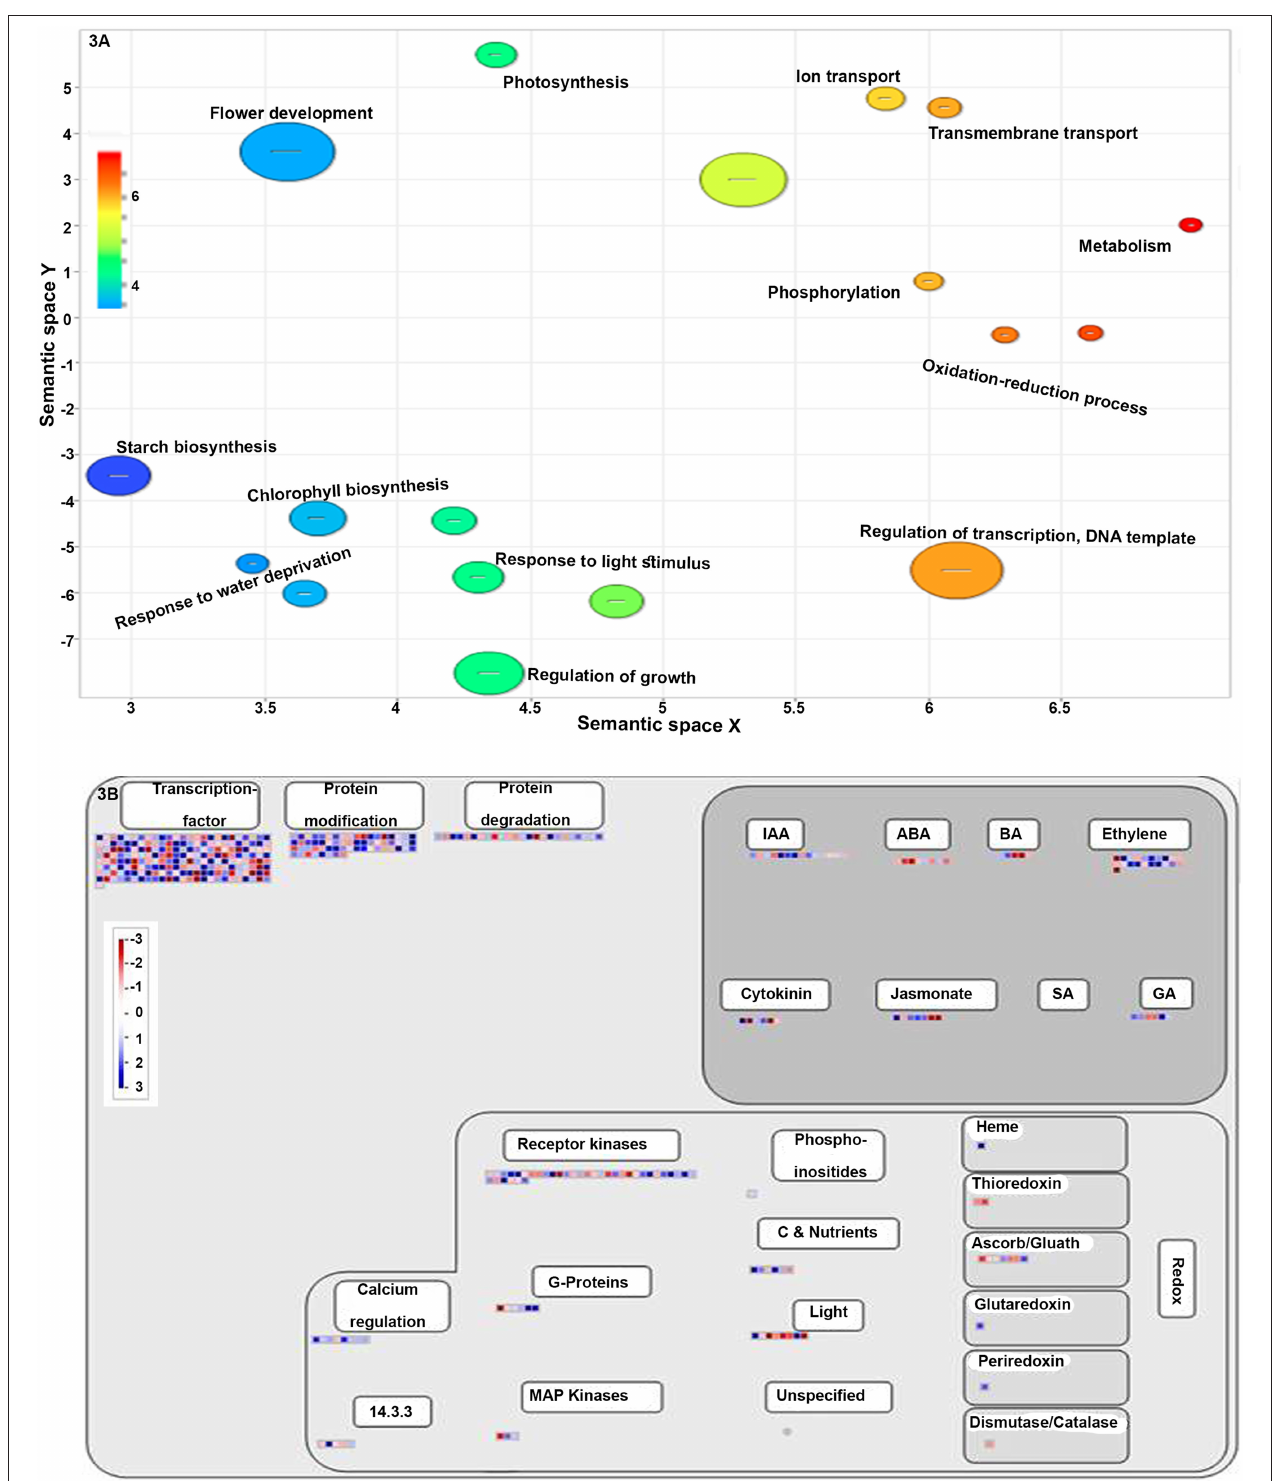
FIGURE 3 | (A) A scatter plot showing the enriched gene ontology (GO) terms in the biological process. Different shades in circles indicate the difference in the value of P as indicated in scale. All the terms are significantly over-represented at p < 0.01. (B) MapMan-based classification of NUE-related genes involved in regulation. Red and blue color boxes represent the upregulated and downregulated NUE-genes, respectively.